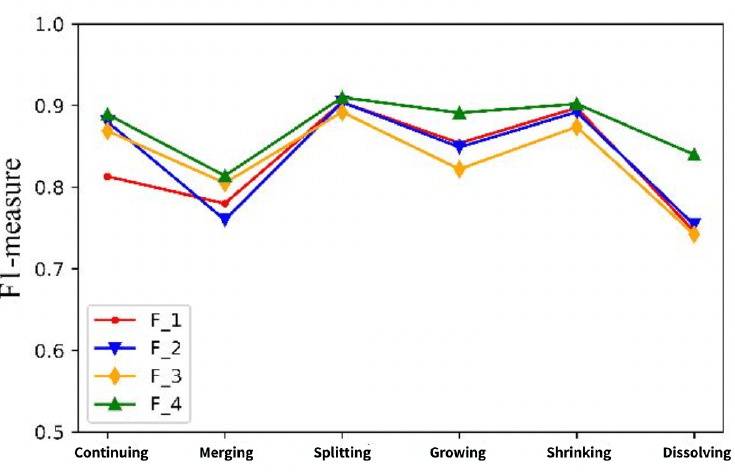
Figure 10. Bitcon dataset prediction